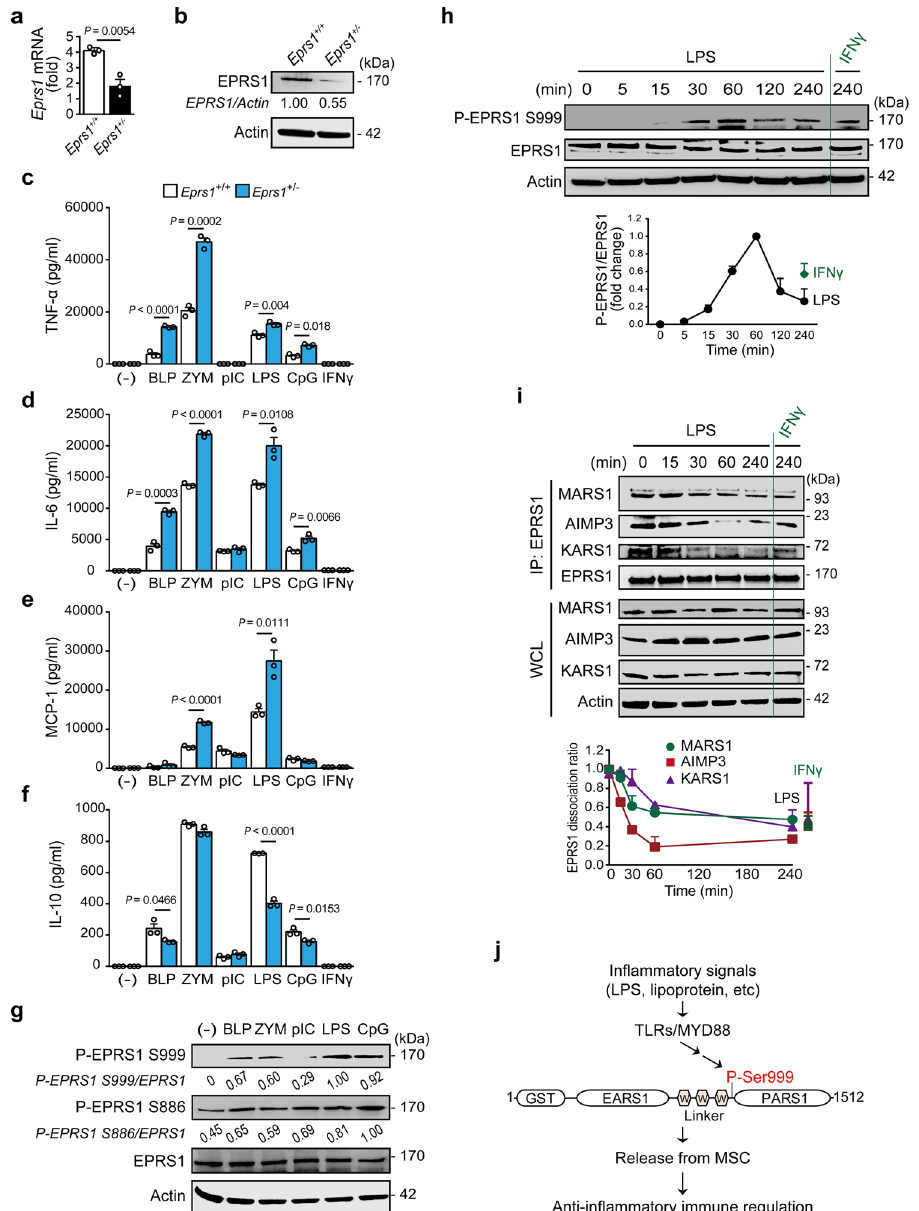
Fig. 1 | TLR-mediated in fl ammatory signaling triggers EPRS1 phosphorylation andsubsequentreleasefromtheMSCtonegativelyregulatein fl ammation.a , b Acomparisonofthelevelsof Eprs1 mRNA( a )andEPRS1protein( b )inheterozygous Eprs1 +/ − mouse-derived BMDMs and WT BMDMs. The ratio of EPRS1 to actin is shown. c – f Enzyme-linked immunosorbent assay of the levels of the cytokines TNF- α ( c ), IL-6 ( d ), MCP-1 ( e ), and IL-10 ( f ) in supernatants from BMDMs isolated from Eprs1 +/+ and Eprs1 +/ − mice stimulated with TLR ligands or IFN γ (100ng/ml) for 24h. Bacterial lipoprotein Pam3CSK4 (BLP, 100ng/ml), zymosan (ZYM, 10 μ g/ml), poly(I:C) (pIC, 40 μ g/ml), LPS (100ng/ml), unmethylated cytosine-phosphate- guanine dinucleotides (CpG, 1 μ g/ml), and IFN γ (100ng/ml) were